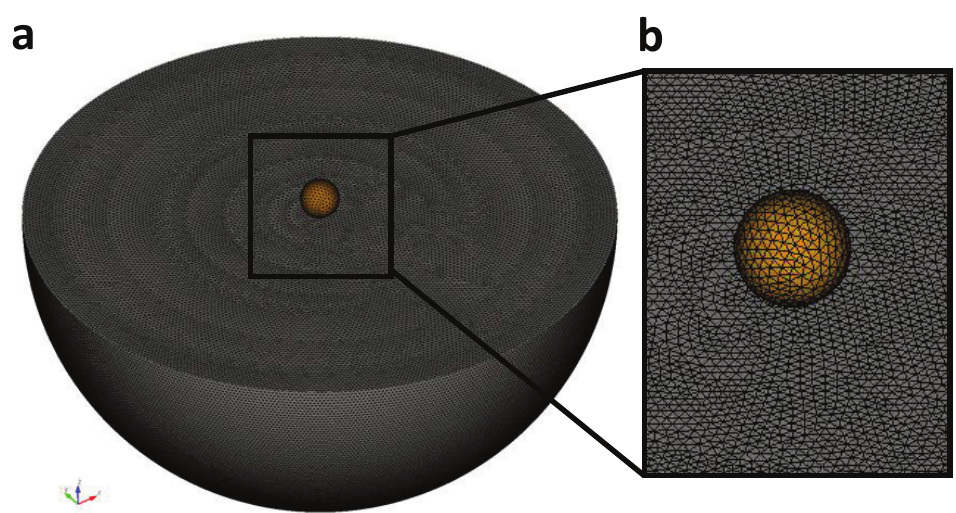
Figure 3. HOSS 3D Simulation domain for an aluminum on aluminum impact, where ( a ) shows the full simulation domain, and ( b ) displays a zoomed in region where the impactor is initialized.